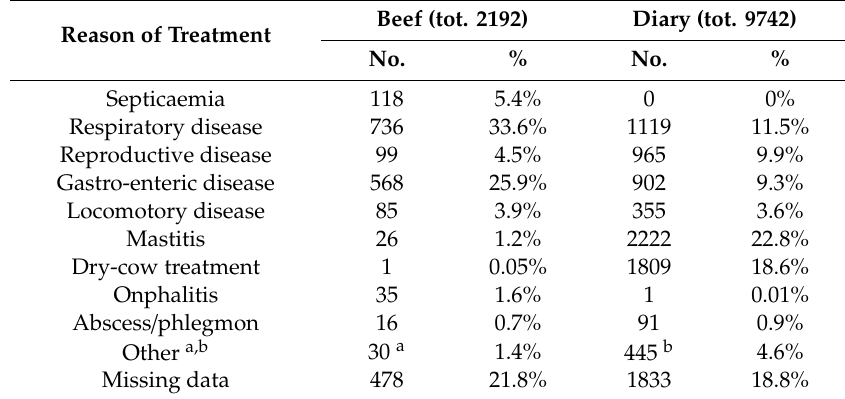
Table A3. Total no. of treated animals during the study period, per livestock category and reason of treatment.